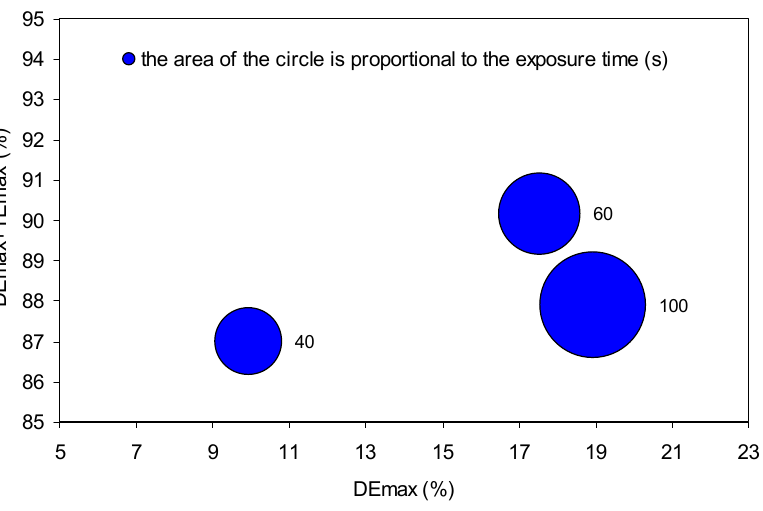
Figure 4. DEmax + TEmax versus DEmax for different exposure times during the hologram recording.